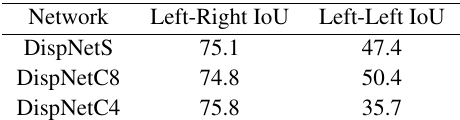
Table 3. Performance of stereo networks with and without the right